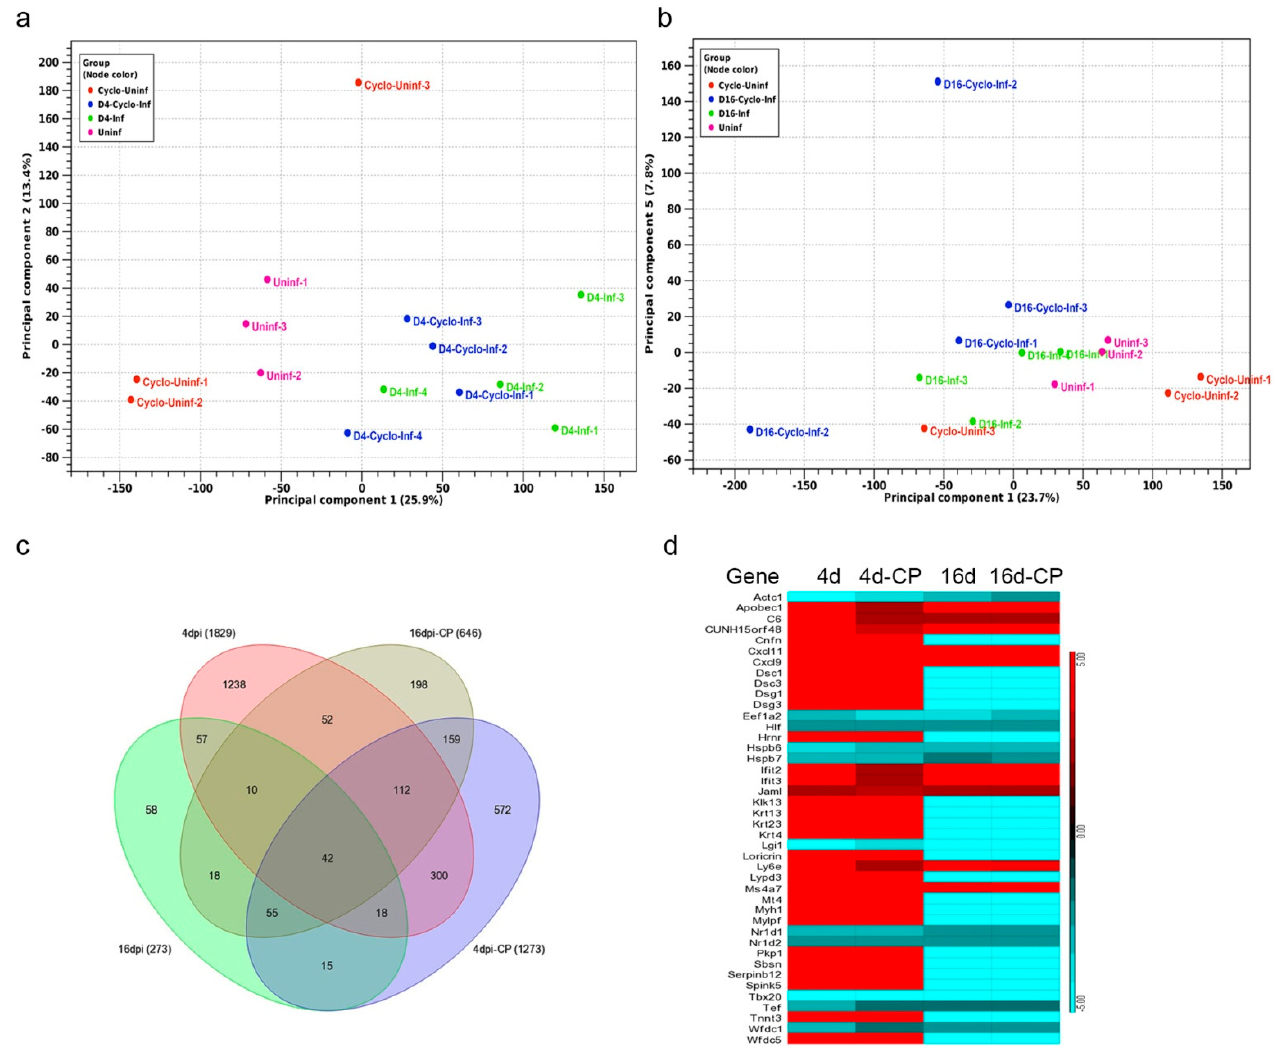
Figure 7. Genome-wide lung transcriptome analysis of immunocompetent and immunocompromised hamsters infected with SARS-CoV-2. ( a ) PCA plot of immunocompetent and immunocompromised hamsters without infection at 4 dpi. ( b ) PCA plot of immunocompetent and immunocompromised hamsters without infection at 16 days post SARS-CoV-2 infection. ( c ) Venn diagram showing the number of significantly differentially expressed genes (SDEG) in the lungs of immunocompetent and immunocompromised hamsters at 4 or 16 dpi. Data from the infected animals were normalized to corresponding uninfected animal data. ( d ) Heat-map of SDEGs commonly perturbed in all four groups. Scale bar shows up (red) and downregulation (cyan). n = 3 per group. Analysis of differentially expressed genes showed a greater number of significantly differentially expressed genes (SDEG) at 4 dpi than 16 dpi in both immunocompetent and immunocompromised animals upon SARS-CoV-2 infection (Figure 7c). However, the number of SDEGs in the immunosuppressed animals was less than in immunocompetent animals at 4 dpi (1273 versus 1829). In contrast, the former group had more SDEGs at 16 dpi (646 versus 273). Thus, immunocompetent and immunocompromised hosts showed distinct gene expression profiles at different stages of infection (i.e., 4 dpi/acute and 16